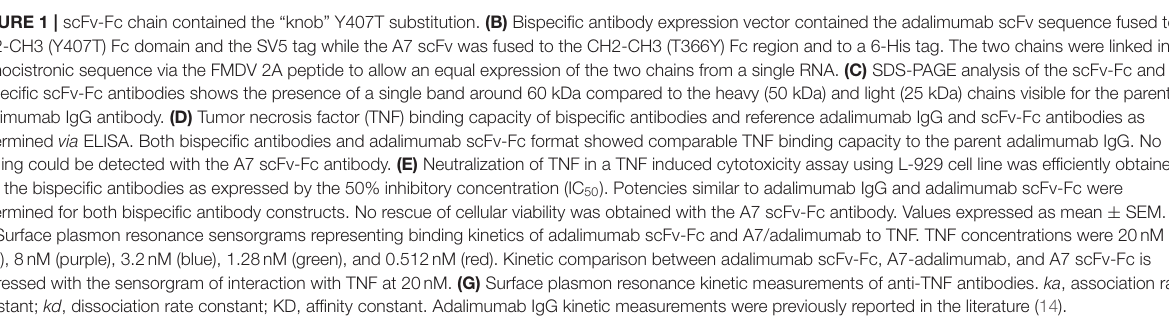
FIGURE 1 | scFv-Fc chain contained the “knob” Y407T substitution. (B) Bispecific antibody expression vector contained the adalimumab scFv sequence fused to the CH2-CH3 (Y407T) Fc domain and the SV5 tag while the A7 scFv was fused to the CH2-CH3 (T366Y) Fc region and to a 6-His tag. The two chains were linked in a monocistronic sequence via the FMDV 2A peptide to allow an equal expression of the two chains from a single RNA. (C) SDS-PAGE analysis of the scFv-Fc and bispecific scFv-Fc antibodies shows the presence of a single band around 60 kDa compared to the heavy (50 kDa) and light (25 kDa) chains visible for the parent adalimumab IgG antibody. (D) Tumor necrosis factor (TNF) binding capacity of bispecific antibodies and reference adalimumab IgG and scFv-Fc antibodies as determined via ELISA. Both bispecific antibodies and adalimumab scFv-Fc format showed comparable TNF binding capacity to the parent adalimumab IgG. No binding could be detected with the A7 scFv-Fc antibody. (E) Neutralization of TNF in a TNF induced cytotoxicity assay using L-929 cell line was efficiently obtained with the bispecific antibodies as expressed by the 50% inhibitory concentration (IC 50 ). Potencies similar to adalimumab IgG and adalimumab scFv-Fc were determined for both bispecific antibody constructs. No rescue of cellular viability was obtained with the A7 scFv-Fc antibody. Values expressed as mean ± SEM. (F) Surface plasmon resonance sensorgrams representing binding kinetics of adalimumab scFv-Fc and A7/adalimumab to TNF. TNF concentrations were 20nM (light blue), 8nM (purple), 3.2nM (blue), 1.28nM (green), and 0.512nM (red). Kinetic comparison between adalimumab scFv-Fc, A7-adalimumab, and A7 scFv-Fc is expressed with the sensorgram of interaction with TNF at 20nM. (G) Surface plasmon resonance kinetic measurements of anti-TNF antibodies. ka , association